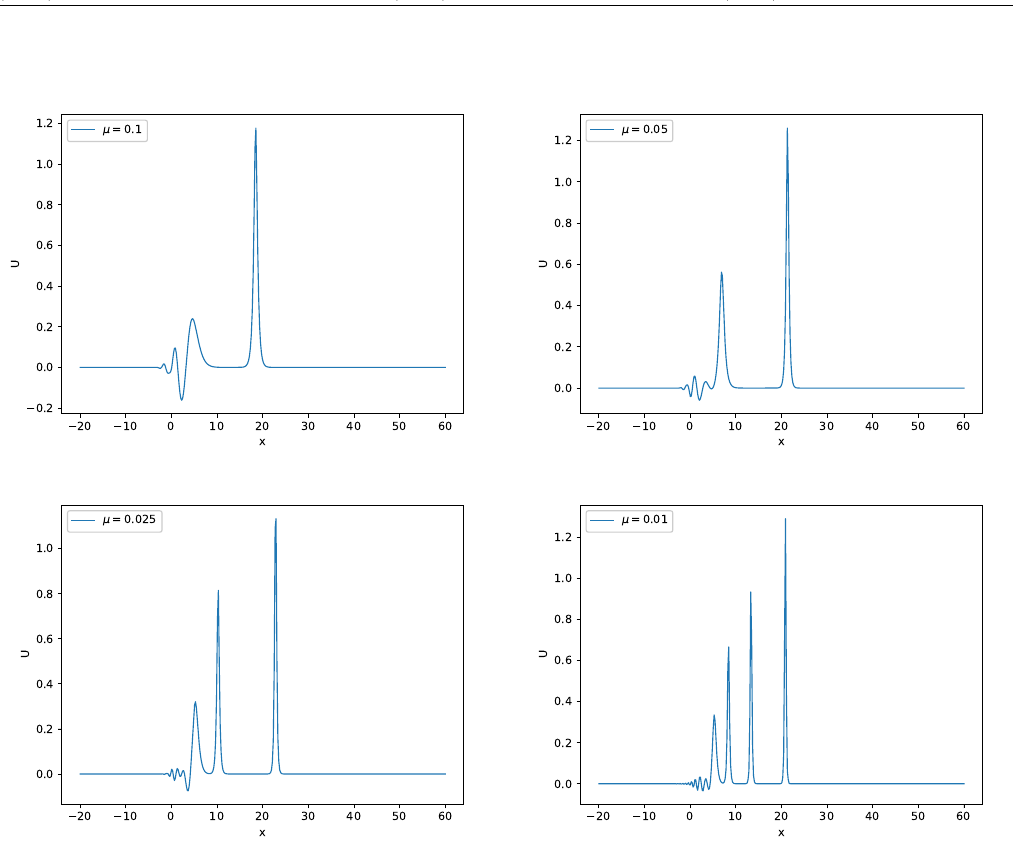
Figure 8. Numerical solution for p = 3, N = 400, ∆ t = 0 . 005 and different values of µ at t = 6. with finite element, finite difference and colloca- by comparing calculated error norms L 2 , L ∞ and invariants I 1 , I 2 , I 3 with exact values and tion methods. It is seen that from